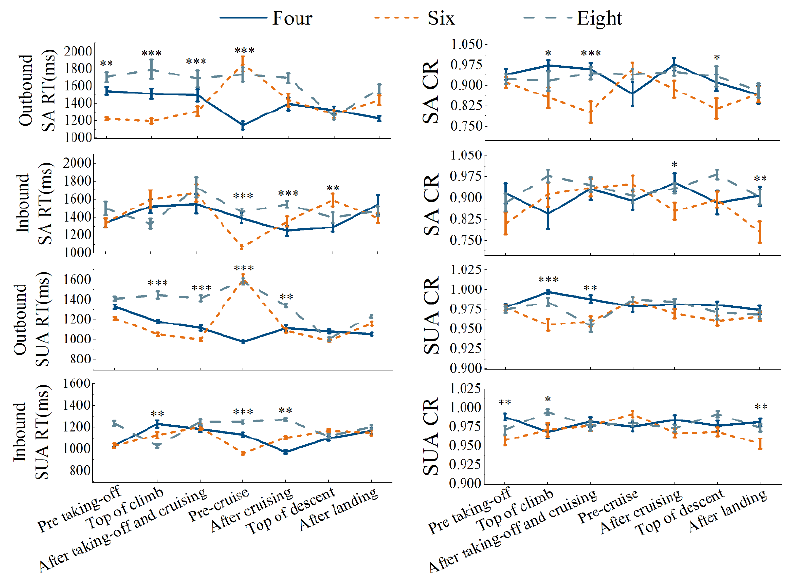
Figure 5. RT and CR of SA and SUA. * p < 0.05; ** p < 0.01; *** p < 0.001. SA denotes selective attention; SUA denotes sustained attention. RT denotes reaction time; CR denotes the correct rate.